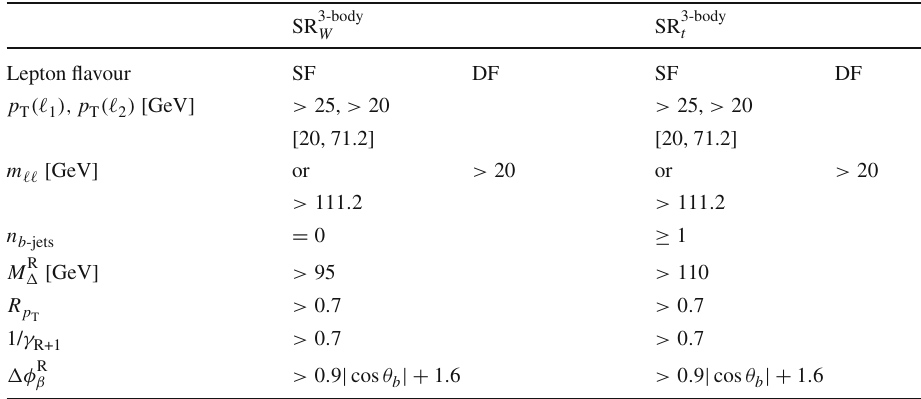
Table 3 Three-body selection signal region definitions